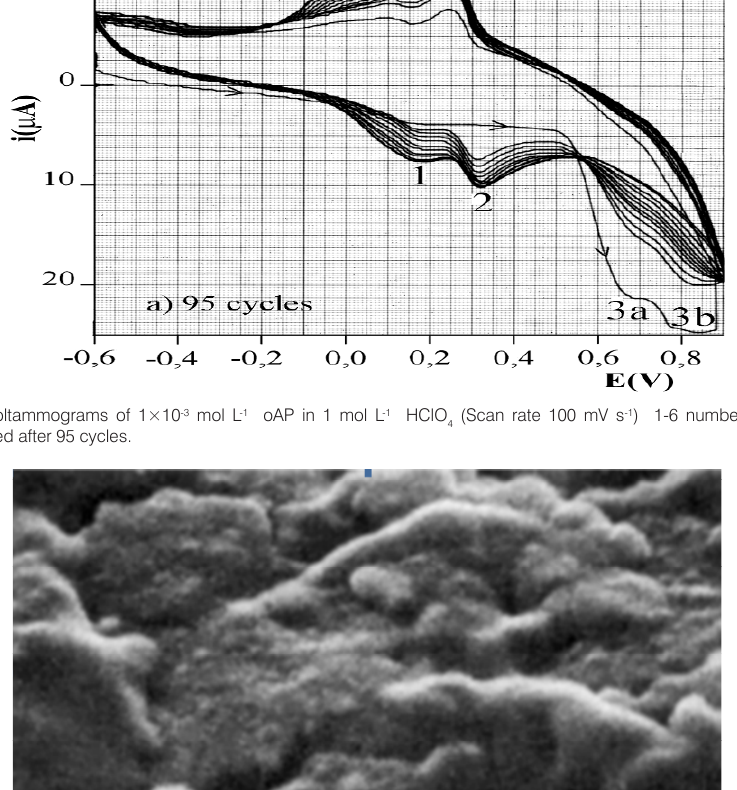
Figure 2. Scanning electron microscopy images of PoAP film (thicknes 13 nm) deposited on the rotating disc gold electrode. Reprinted from [14] with permission from Elsevier.